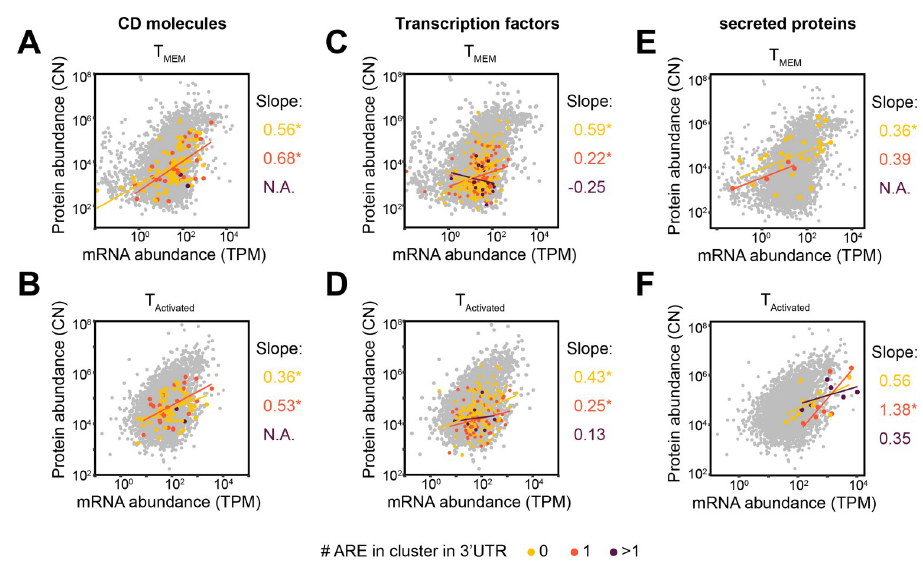
Fig 6. ARE cluster content differentially affect gene classes. ( A-F ) Integrated mRNA (TPM) and protein (CN) abundance of genes co-detected at mRNA and protein levels, for ( A, B ) CD molecules, ( C, D ) transcription factors, or ( E, F ) secreted proteins. Genes were stratified according to the number of AU-rich element in cluster within the transcript’s 3’UTR, for ( A, C, E ) T MEM or ( B, D, F ) T Activated CD8 + T cells. The linear regression and its slope are color- coded for each group. Difference between groups were assessed with a two-tailed t-test followed by adjustment of p- value using the Benjamini-Hochberg procedure. Adjusted p-value are indicated. TPM: Transcripts per kilo-base per million; CN: Protein copy number. “ � ” indicates correlation and regression with p-value < 0.05.